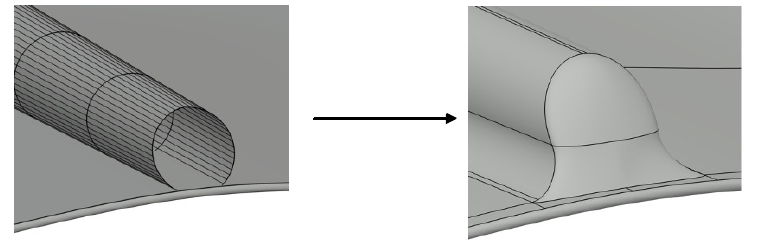
Figure 3. Closure of the open tube geometry: original CAD model on the ( left ) and closed geometry on the ( right